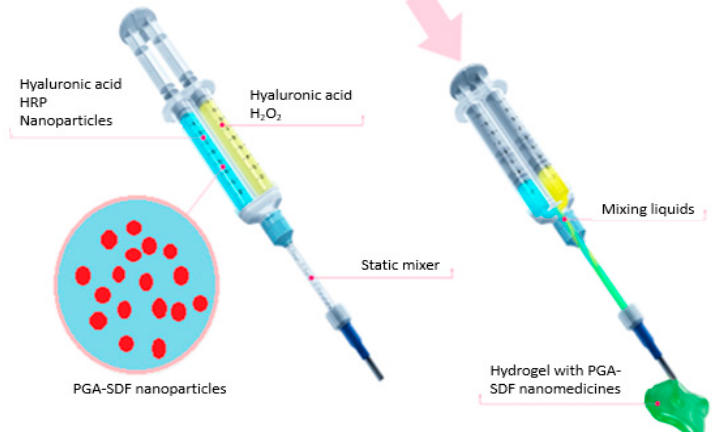
Figure 2. Double syringe injection system used to formulate the star–poly(glutamic acid)